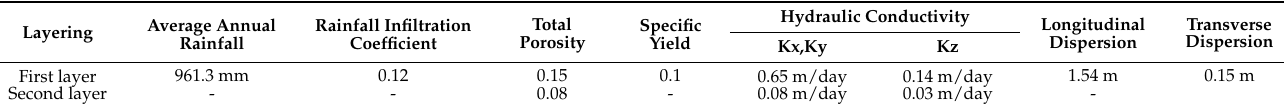
Table 2. Model parameter values used in numerical